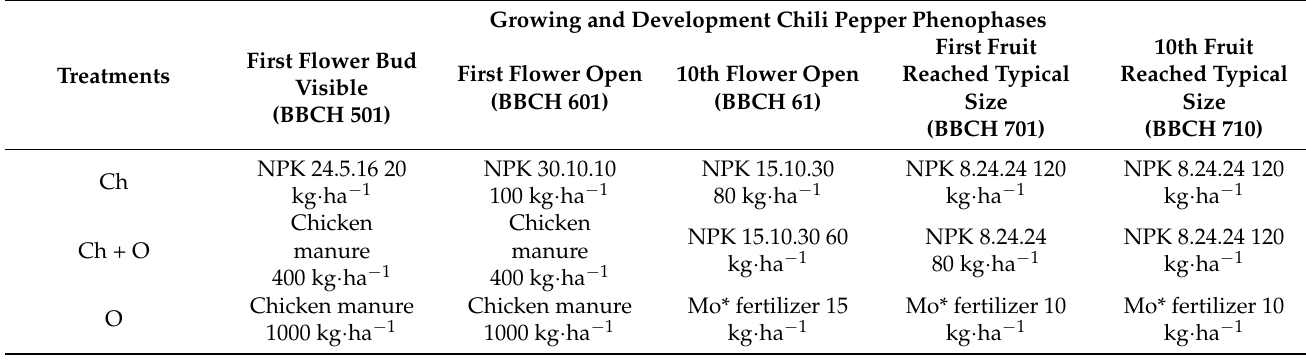
Table 1. Experimental design of the treatments according to